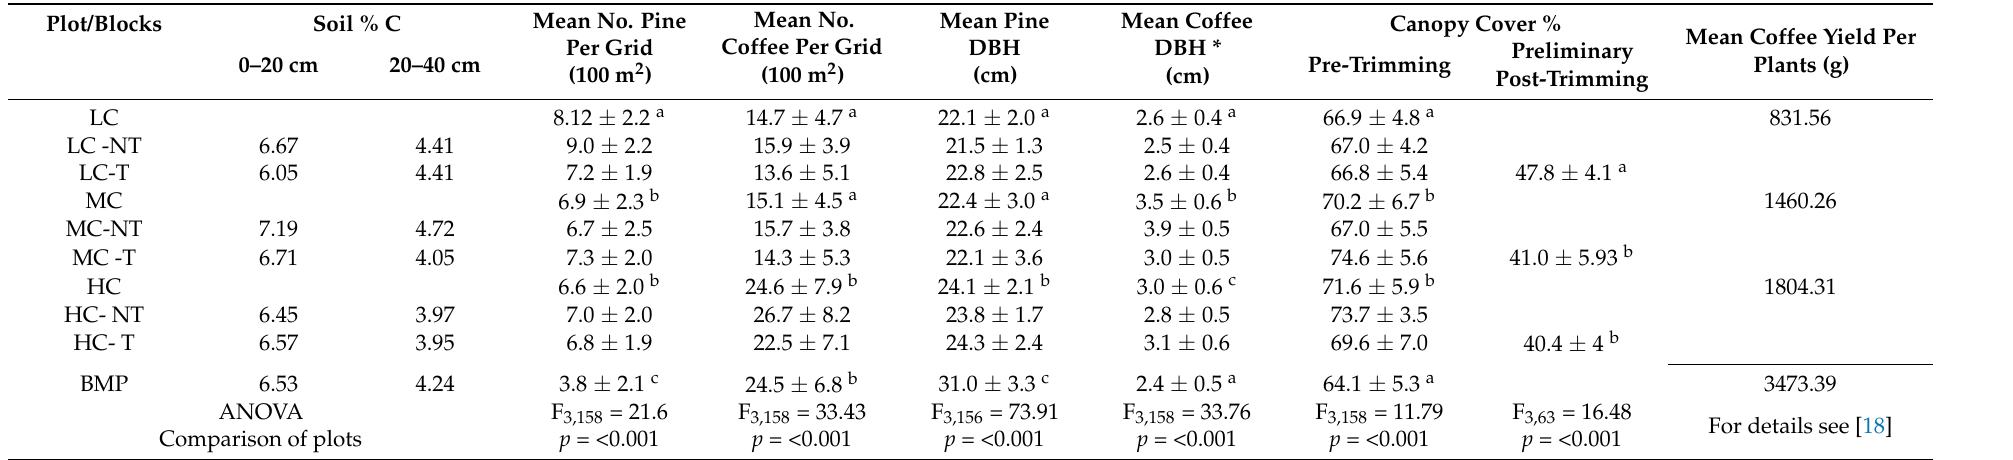
Table 1. Summary of key plot characteristics measurements and comparison of plot level differences using one way Anova and Tukey post hoc testing of significant main effect. Same superscript letters indicates no significant difference in comparison of plot level values. Means are based on a per grid value ( n = 24) and excludes MC trimmed plot grids D1–6 and C6. Post-trimming canopy cover percentage cover values are preliminary as they are based on one measurement per grid in contrast to the 5 measurements per grid taken